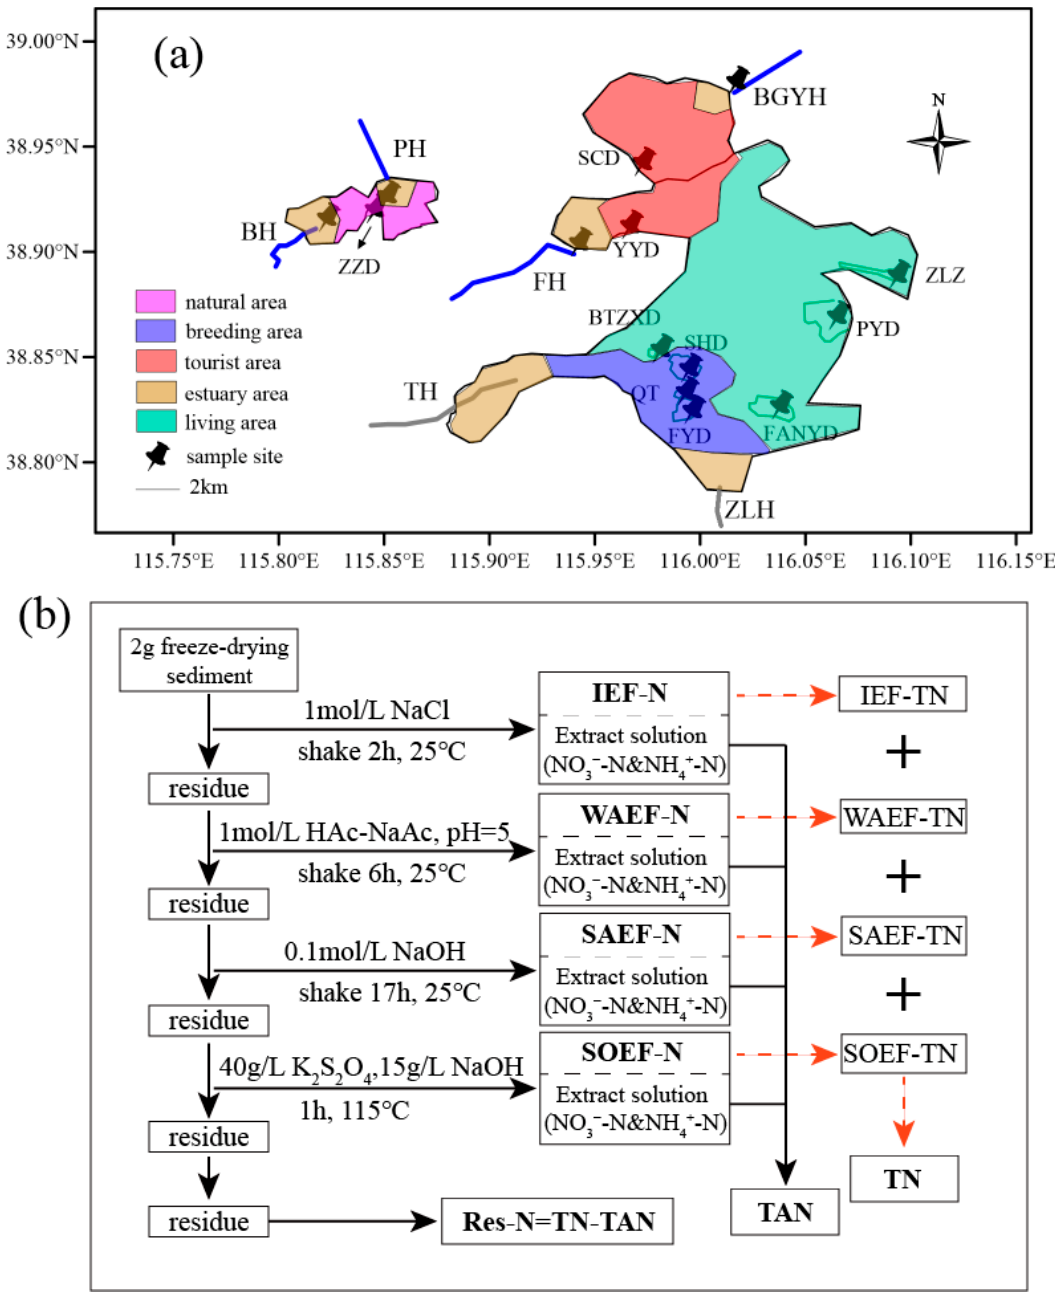
Figure 1. The sample sites and sequential extraction process of sediment N fractions in Baiyangdian Lake. ( a ), the map of sample sites; ( b ), the sequential extraction process of sediment N fractions.